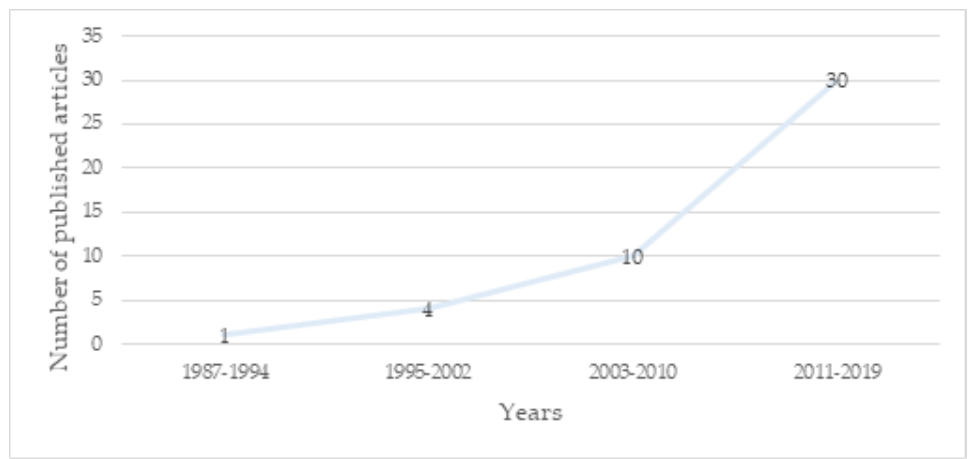
Figure 2. Graph of the number of publications in different countries.